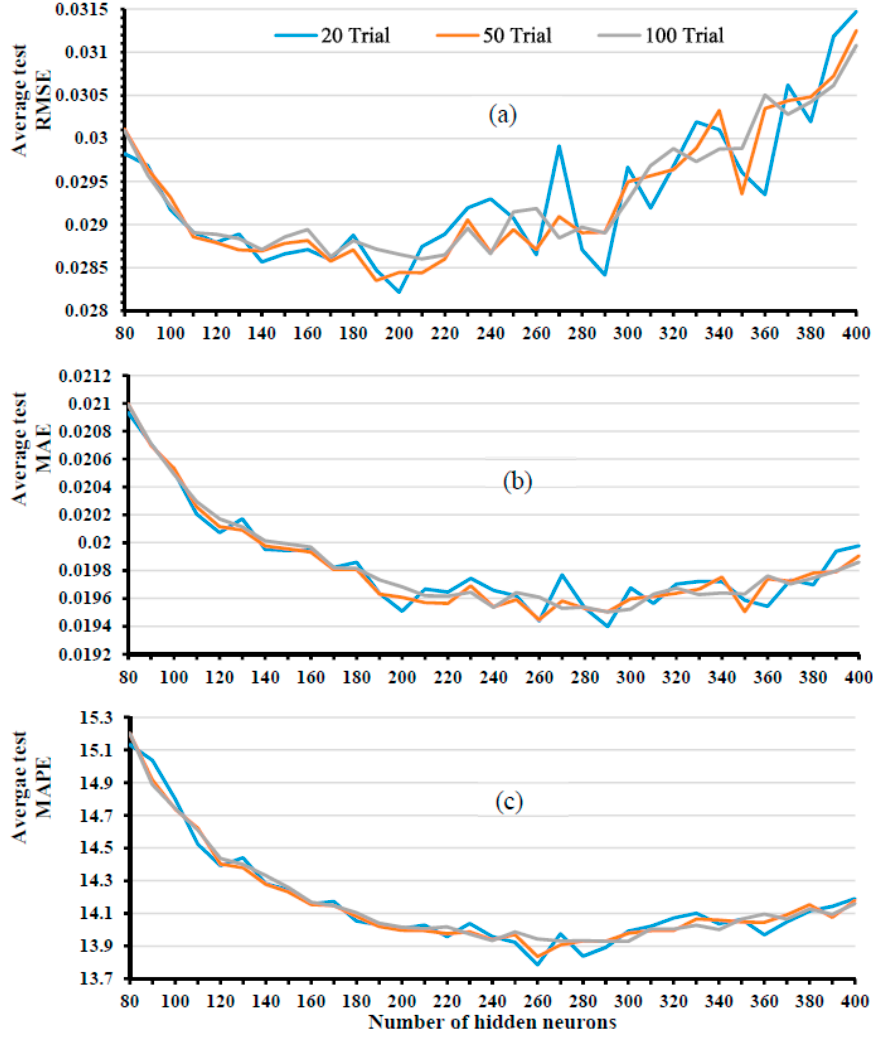
Figure 4. Evolution of average errors in ELM model by changing the number of trials.